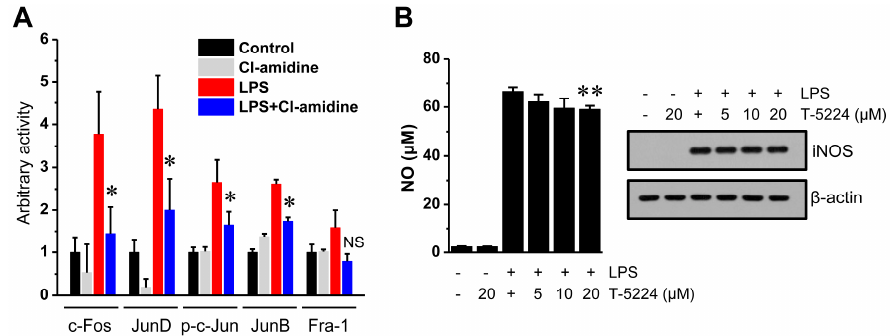
Figure 5. Cl-amidine impairs LPS-induced AP-1 family activity. ( A ) Nuclear proteins (10 μ g) isolated from DCs (1 × 10 7 cells) were stimulated with LPS (0.1 μ g/mL) with or without Cl-amidine (200 μ M) for 1 h, and then c-Fos, JunD, p-c-Jun, JunB, and Fra-1 activity was measured as described in the Materials and Methods (mean ± SD; n = 3). * p < 0.05. NS, not significant. ( B ) After DCs (5 × 10 5 cells or 5 × 10 6 cells) were incubated with the AP-1 inhibitor T-5224 for 2 h, cells were stimulated with LPS for 24 h, and then NO production ( left panel) and iNOS expression ( right panel) were assessed by ELISA and Western blotting. ** p < 0.01.